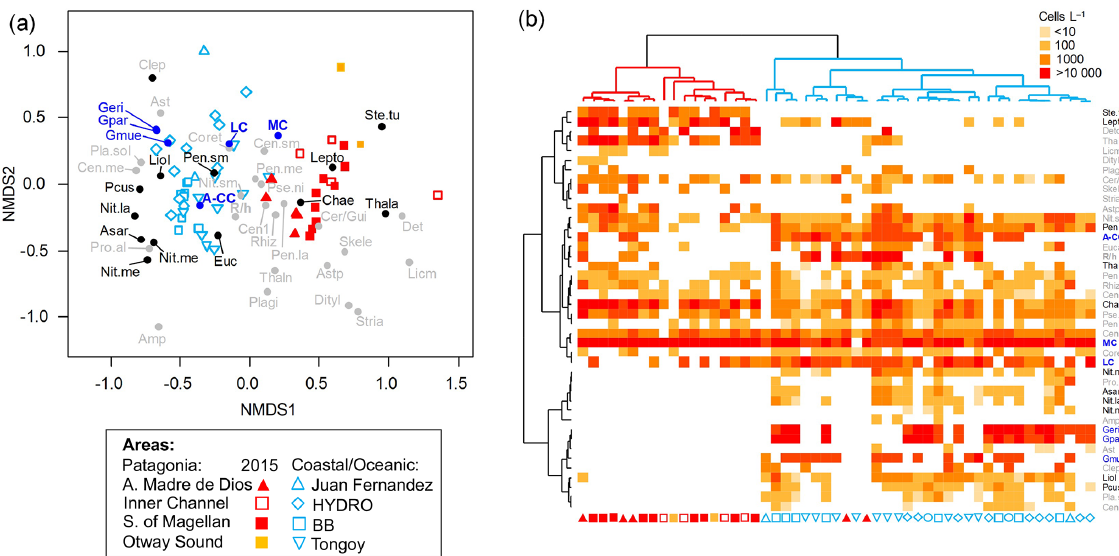
Figure 7. (a) Non-metric multidimensional scaling (nMDS) based on coccolithophore and diatom abundances attained in southern Patag- onia fjords during late spring 2015 (this study) and other coastal/oceanic areas (data from von Dassow et al., 2018). (b) Heatmap showing abundances of coccolithophore and diatom species used in the nMDS. The horizontal dendrogram (based on the nMDS sample scores) shows a clear separation between Patagonia fjords (red cluster) and coastal/oceanic (blue cluster) areas, whereas the vertical dendrogram (based on the nMDS species scores) indicates the separation of species in two main clusters. Black and blue species labels depict species with significant values in the IndVal analysis. A-CC: Emiliania huxleyi A-CC morphotype; Amphi: Amphiprora spp.; Asar: